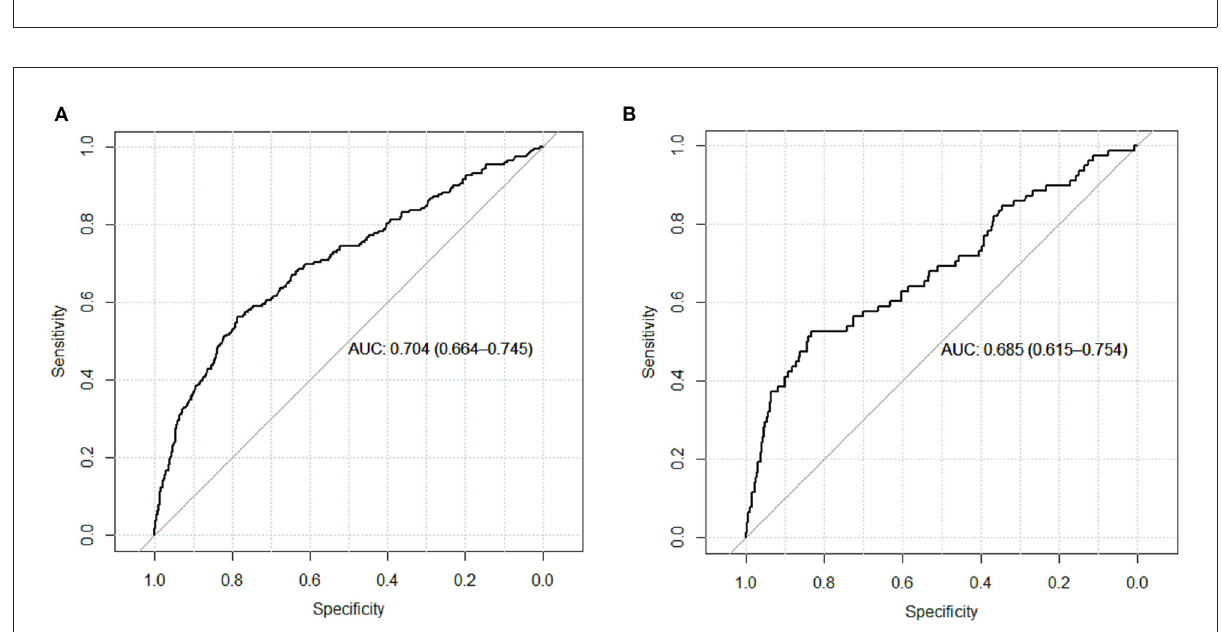
FIGURE4 ROC curves for PVT prediction model in the training set (A) and validation set (B)